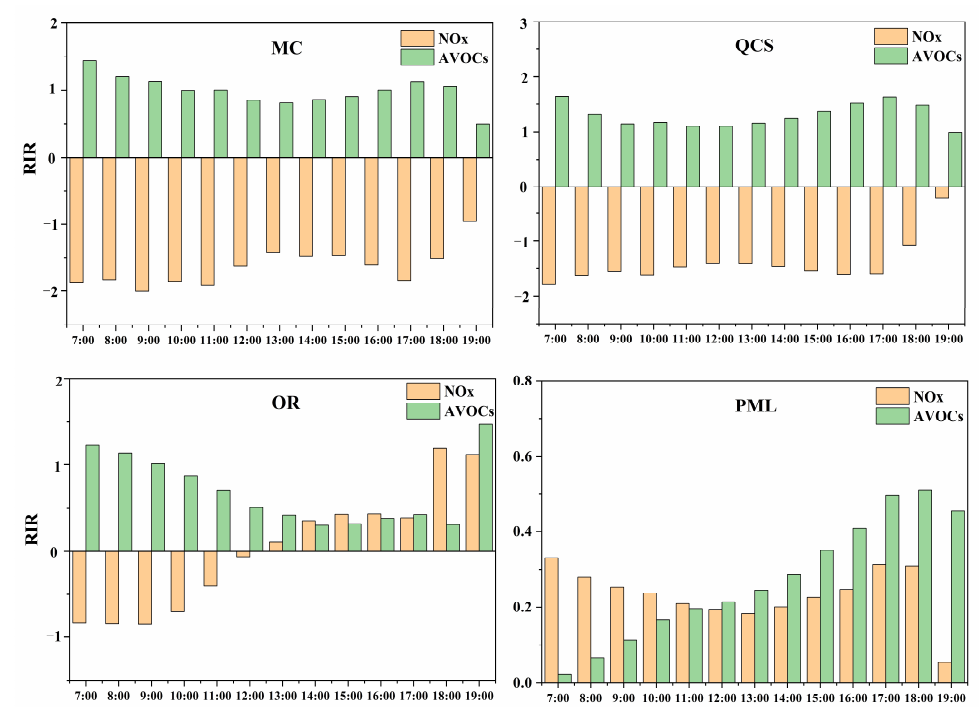
Figure 11. Relative incremental reactivity value (RIR) of ozone precursors at different times at each site.